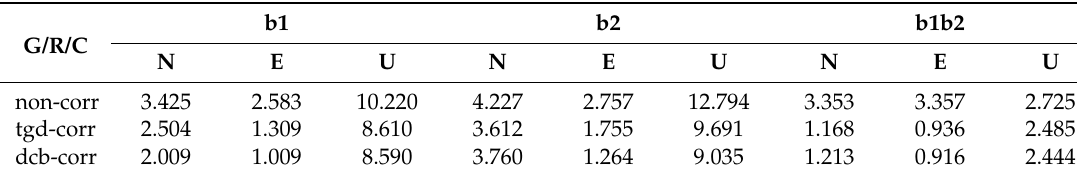
Figure 15. Positioning error series of b1b2 kinematic GPS/BDS/GLONASS SPP. Table 6. RMS of multi-constellation SPP (unit: